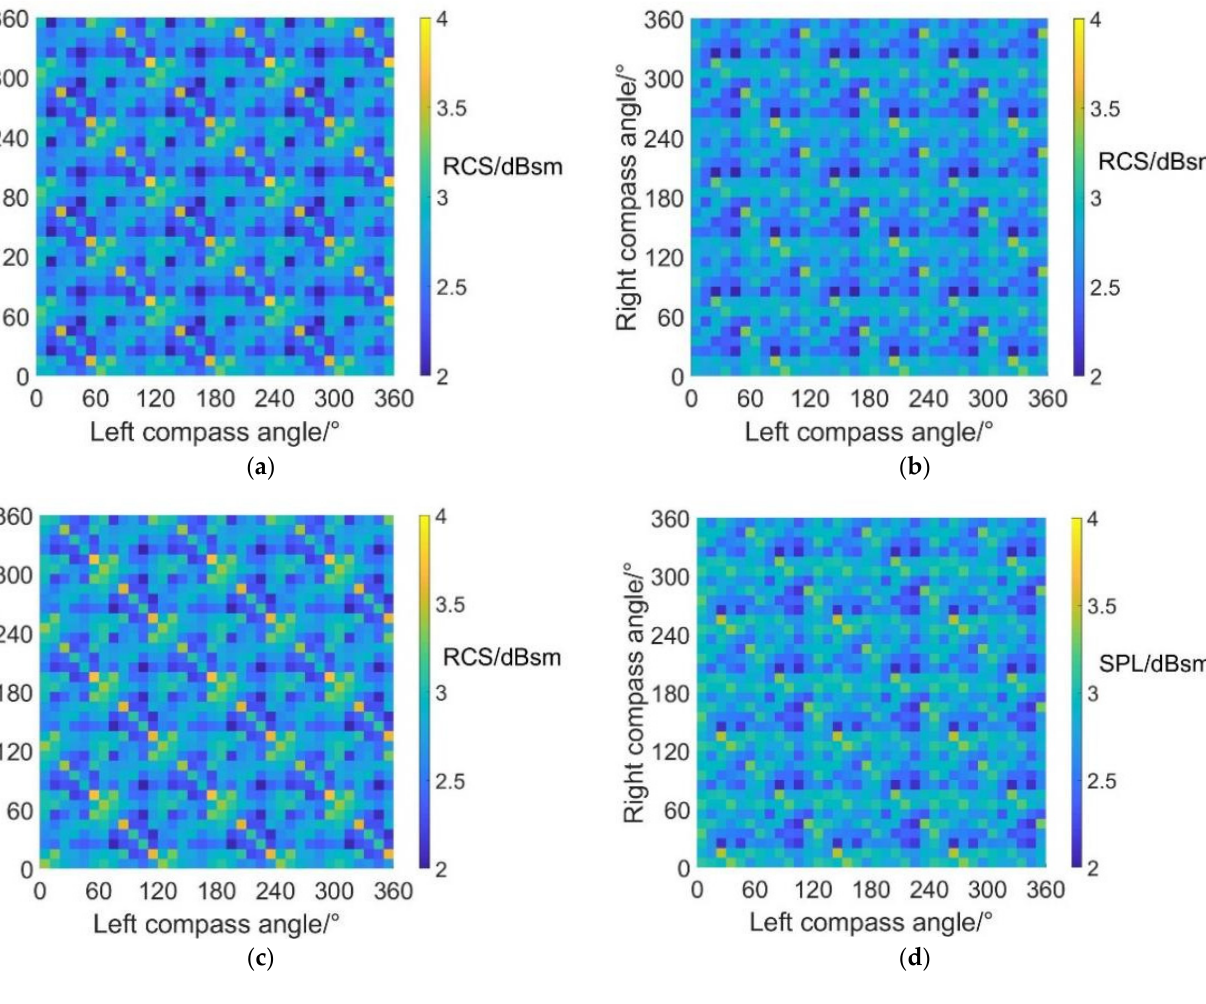
Figure 21. Carpet diagrams of average RCS in fixed-wing mode at an azimuth angle = 180 ◦ with scissors angle difference = ( a ) 0 ◦ , ( b ) 30 ◦ , ( c ) 60 ◦ , ( d ) 90 ◦